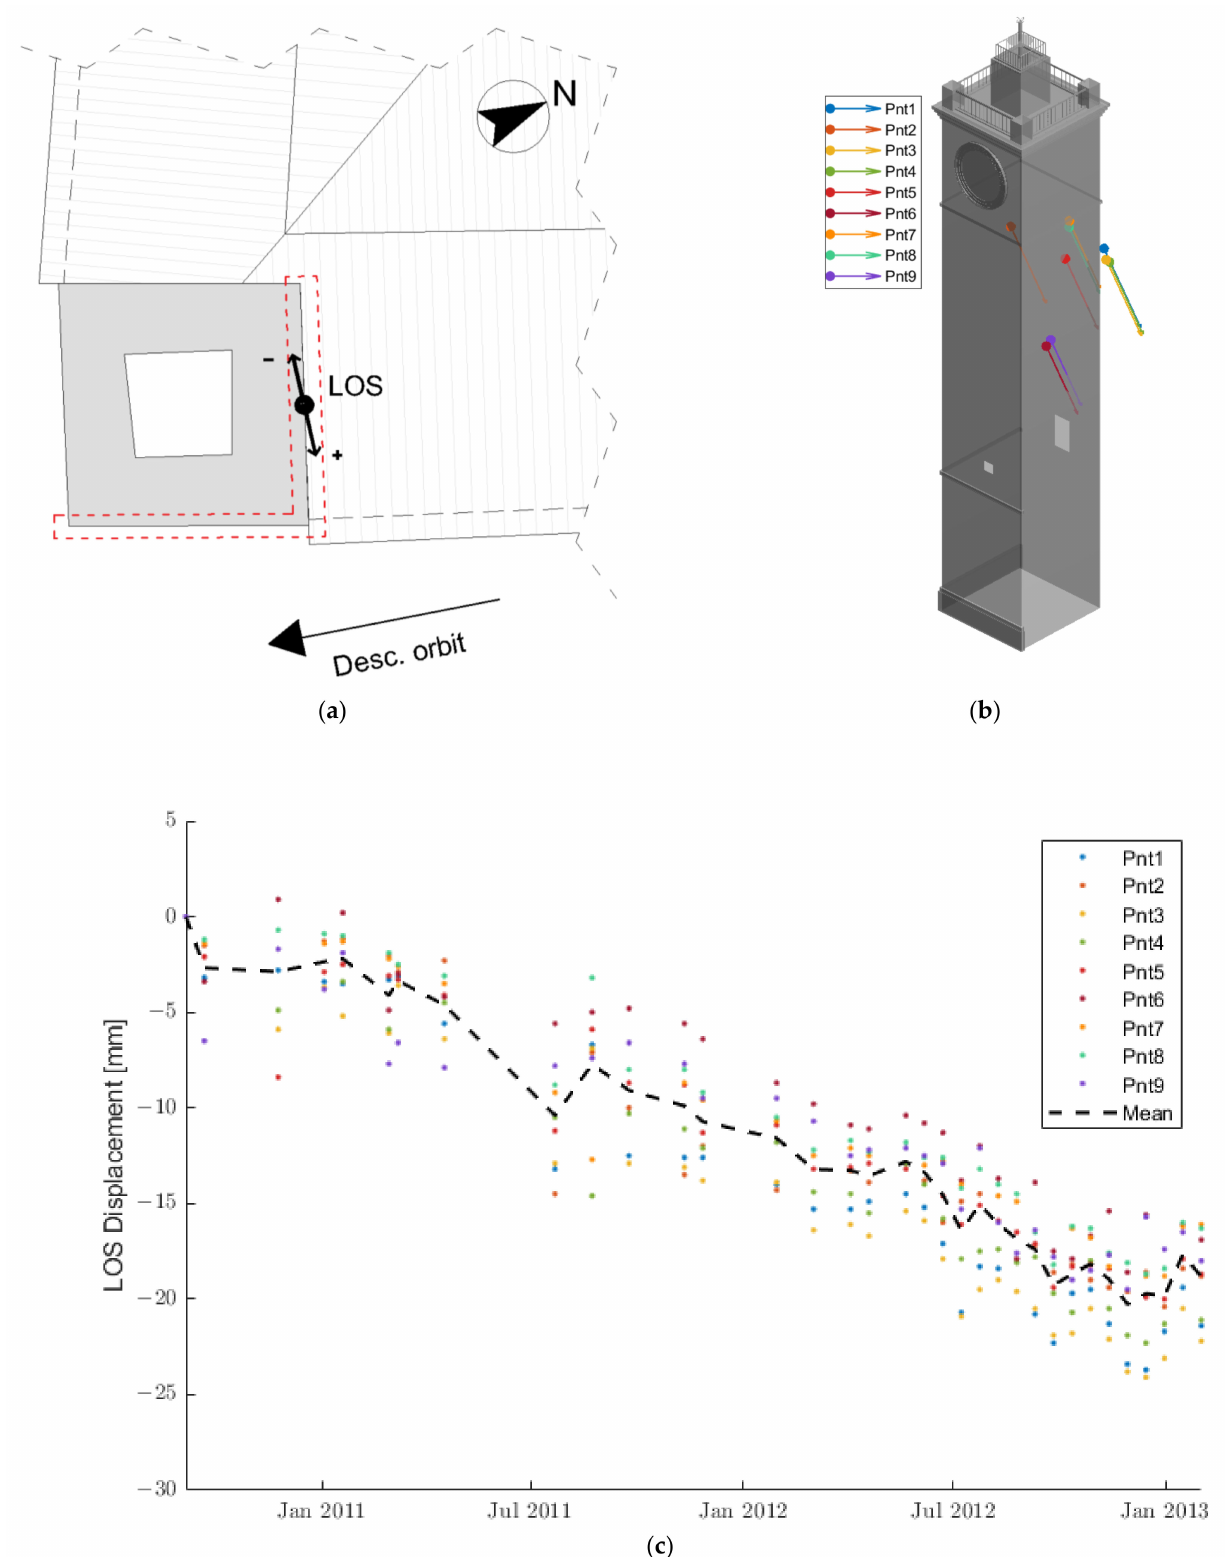
Figure 8. Sketch of the Civic Tower’s walls backscattering the radar signal to the satellite ( a ), distribution of the PSs along the tower’s height ( b ), displacement time series of each point ( c